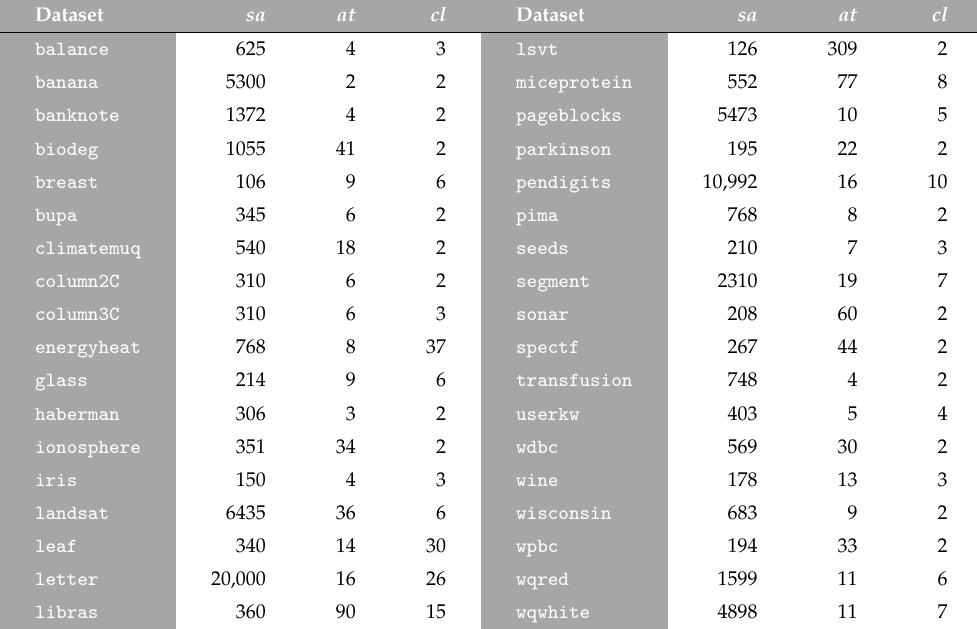
Table 1. Datasets used, along with their number of samples ( sa ), attributes ( at ), and classes ( cl ).